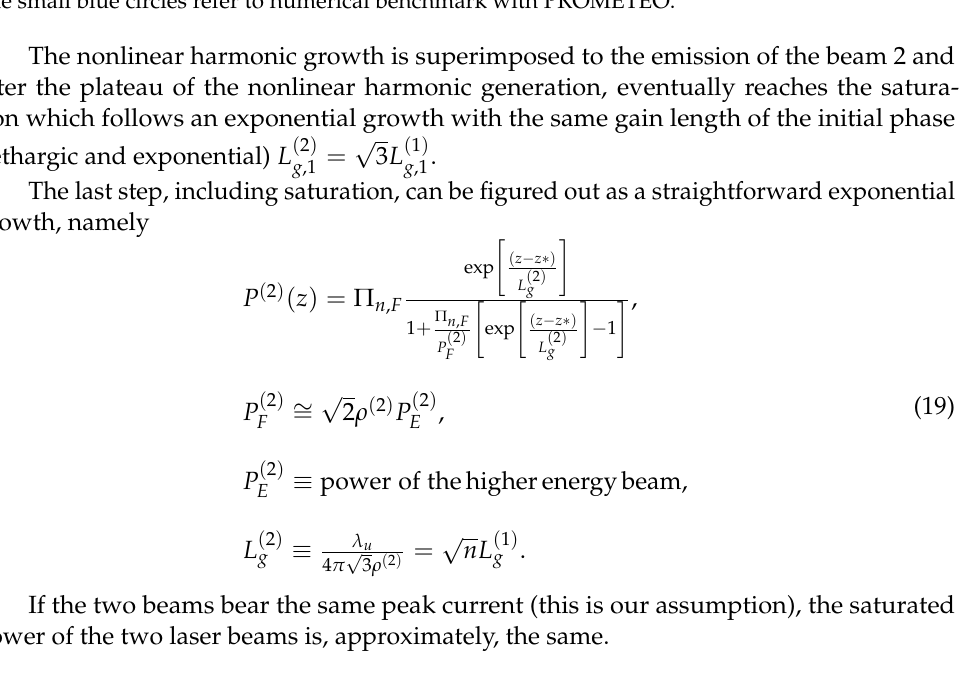
Figure 3. Intensity associated with the FEL action of the low energy beam (continuous red), and of the higher energy beam (dashed blue). The green circle stresses the same comment regarding Figure 1. The small blue circles refer to numerical benchmark with